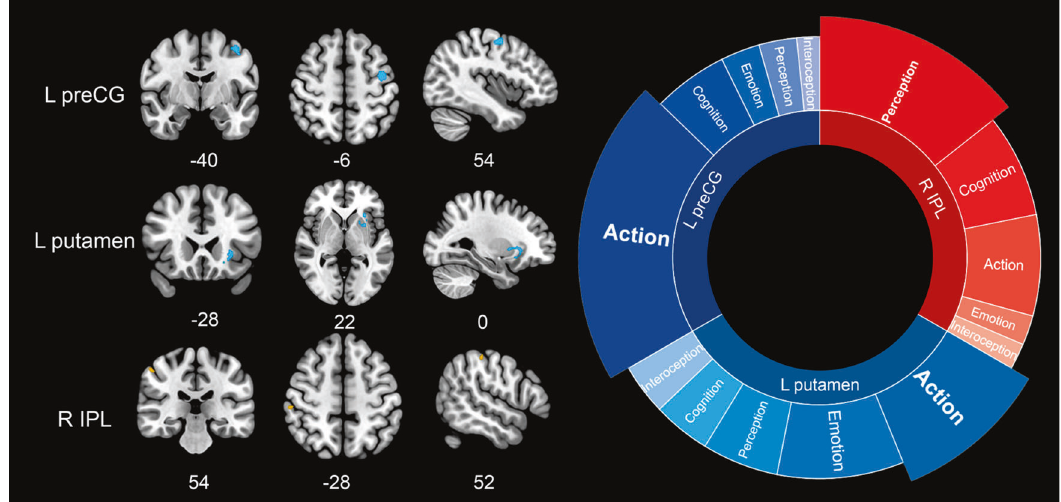
Fig. 3 Comparative brain abnormalities of attention de fi cit/hyperactivity disorder (ADHD) to substance use disorders (SUDs) and their corresponding functioning. Clusters were exhibited in the sagittal, axial, and coronal planes at p < 0.001, z > 1, and cluster size > 10 voxels. Increased GMV patterns of ADHD relative to SUDs were shown in orange while decreased patterns in blue. Results of functional decoding presented contribution of each behavioral domain to each suprathreshold cluster. L Left, R Right, preCG Precentral gyrus, IPL Inferior parietal